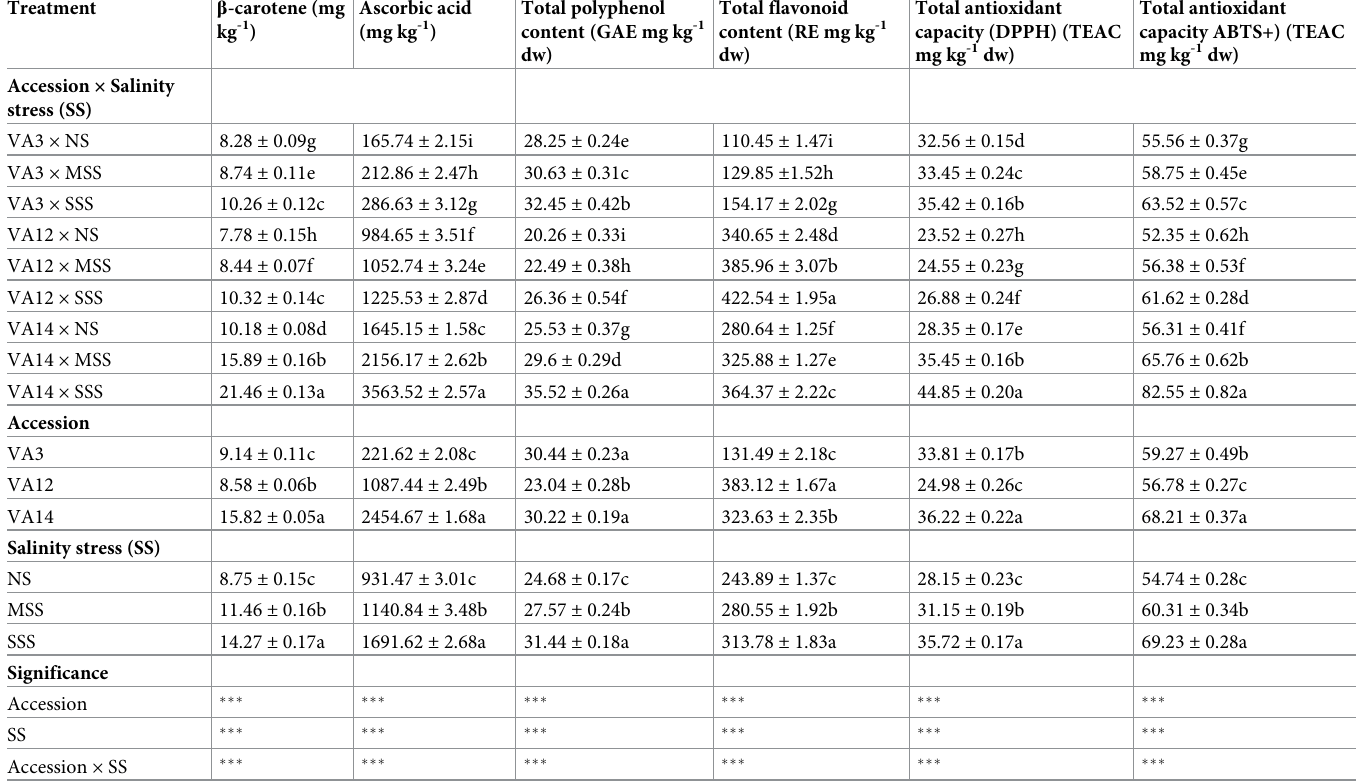
Table 3. Salinity effects on antioxidant phytochemicals and antioxidant capacity in three selected A . tricolor accessions.